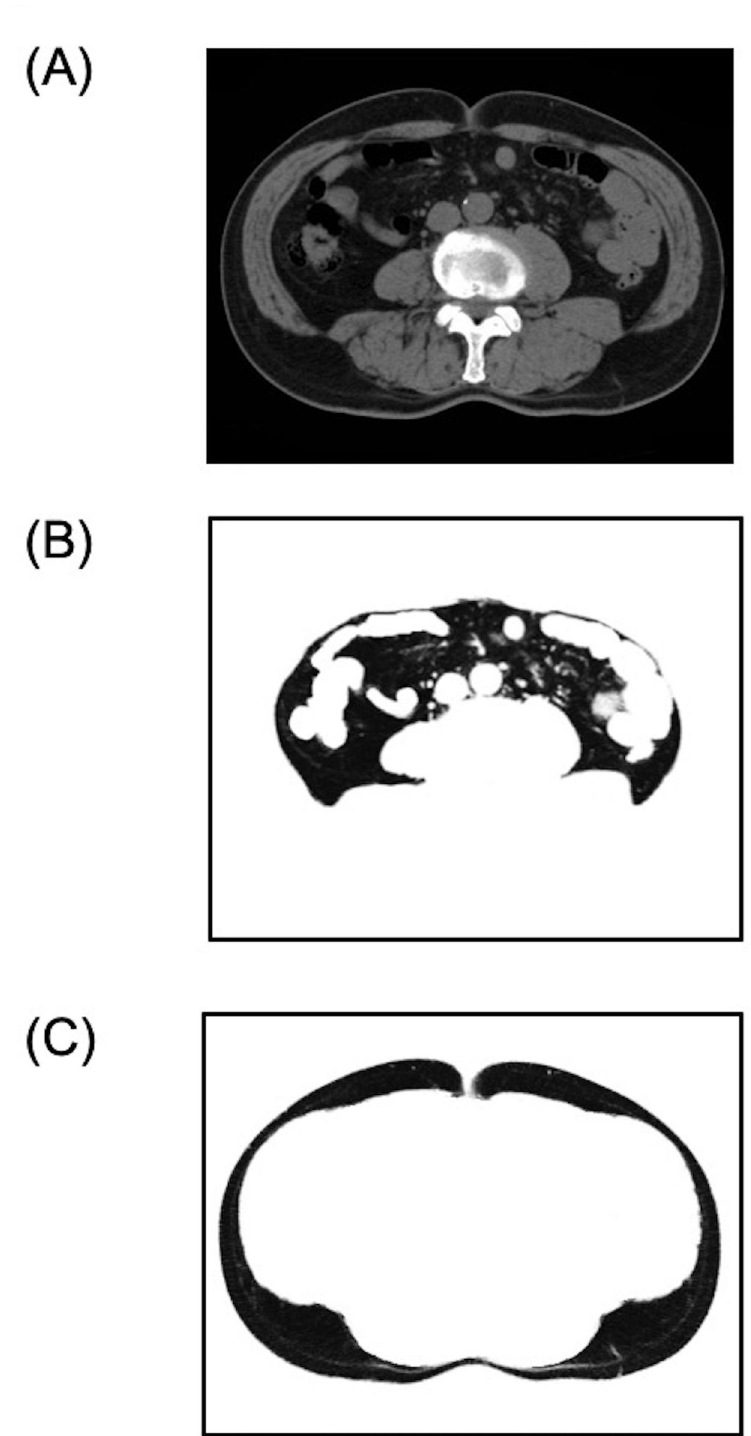
Fig 1. Measurements of fat using computed tomography. (A) An axial slice of a representative computed tomography image at the level of the umbilicus. (B, C) Visceral fat and subcutaneous fat after segmentation of the fat density